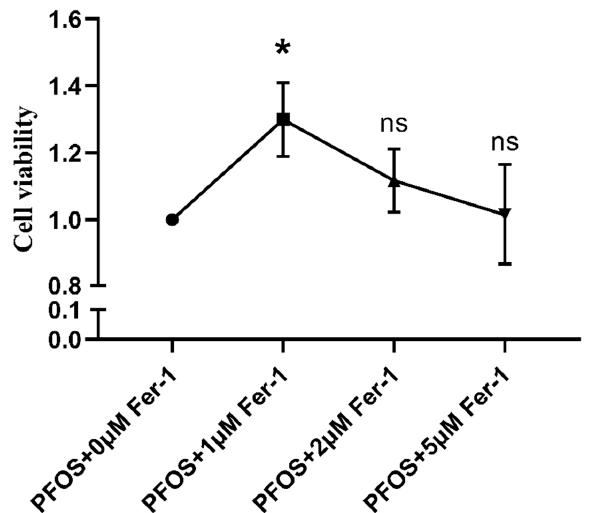
Figure 3. Cell viability after HK-2 cells exposed to PFOS or/and Fer-1. HK-2 cells were exposed to PFOS for 12 h or cultured with Fer-1 for 2 h at the concentration of 0 µ M, 1 µ M, 2 µ M and 5 µ M prior to exposure to PFOS and CCK-8 was used to detect the cell viability; the results were from three independent experiments. Cell viability was expressed as mean ± SD (n = 3); * vs. control, p < 0.05; ns—no significant difference.